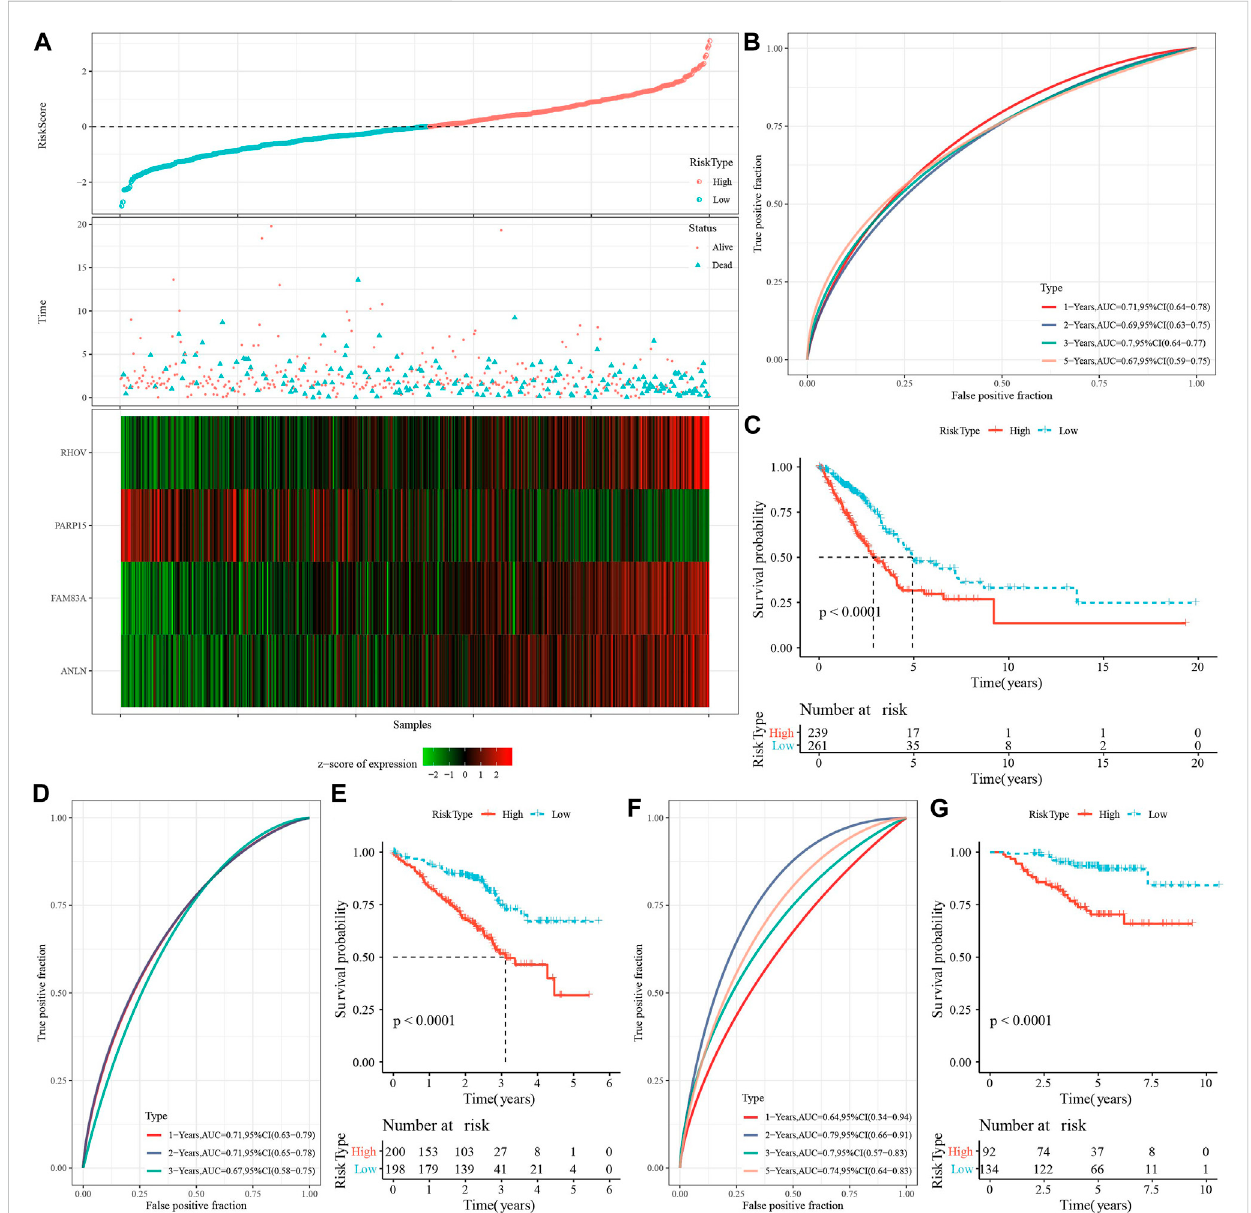
FIGURE 7 Risk modeling and validation. (A) RiskScore, survival time vs. survival status and expression of necroptosis-related genes in TCGA-LUAD dataset. (B) ROC curves with AUC for RiskScore classi fi cation in the TCGA-LUAD dataset. (C) Distribution of KM survival curves for RiskScore in the TCGA-LUAD dataset. (D,E) : ROC curves and KM survival curves for RiskScore in the GSE72094 cohort. (F,G) : ROC curves and KM survival curves of RiskScore in the GSE31210